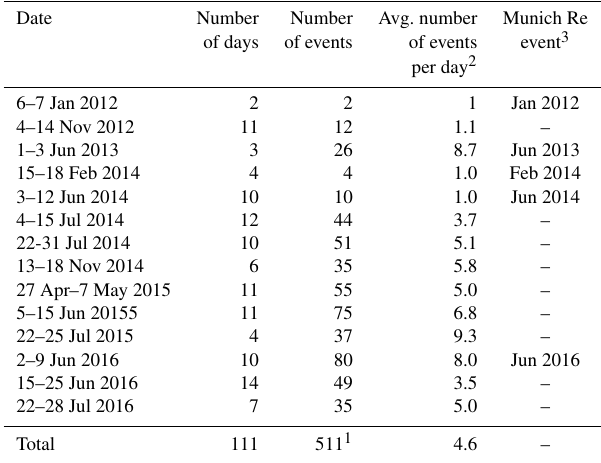
Table 2. Long-lasting rainfalls resulting in 61% of the col- lected natural hazard events on the Swiss transportation network from 2012 to